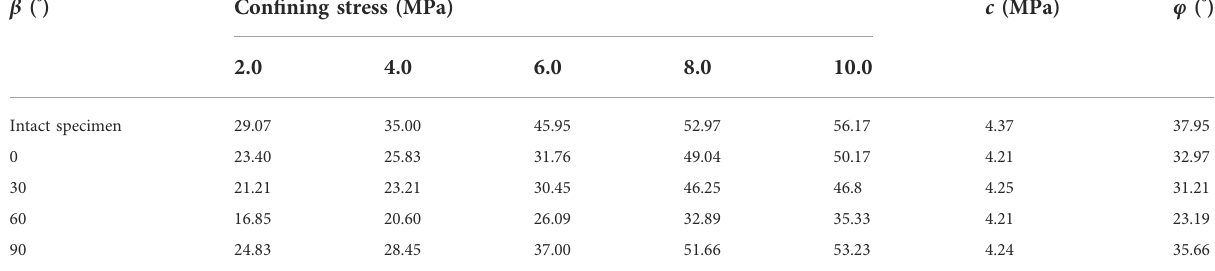
TABLE 3 Compressive strength and mechanical parameters of rock-like samples. β ( °